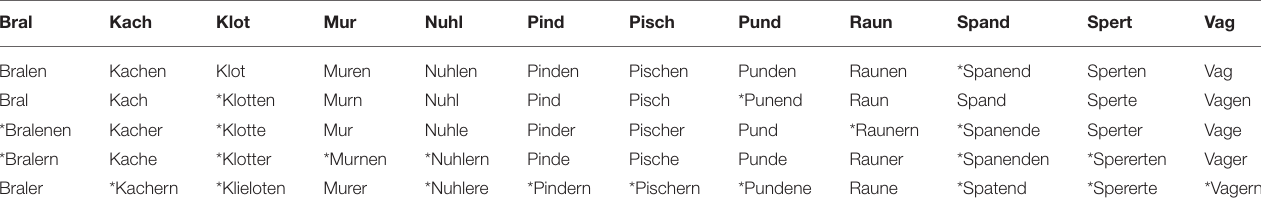
TABLE 7 | First five candidates for the plural forms of non-words. Bral Kach Klot